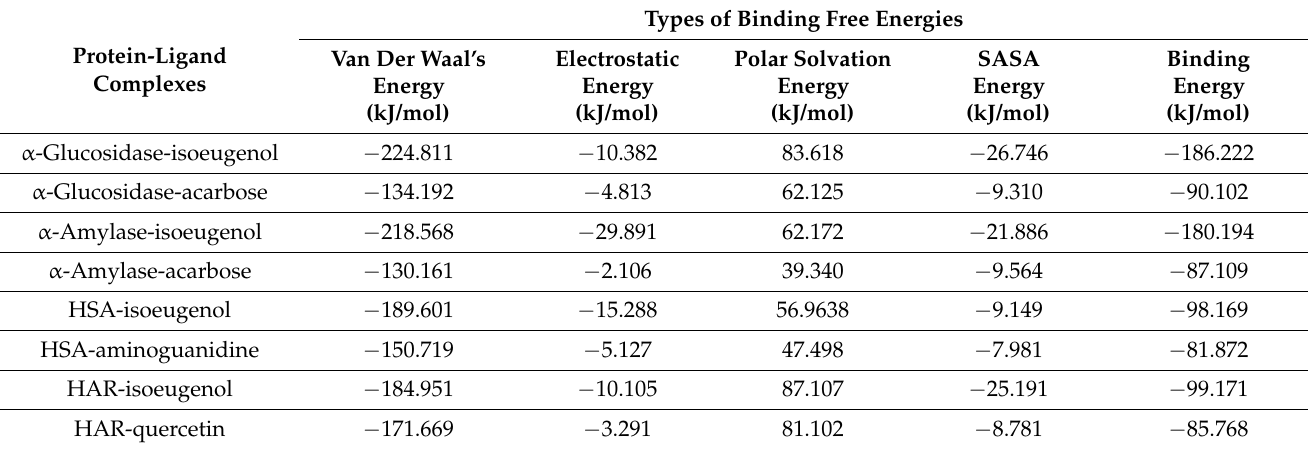
Table 8. Binding free energy values of the target proteins complexed with